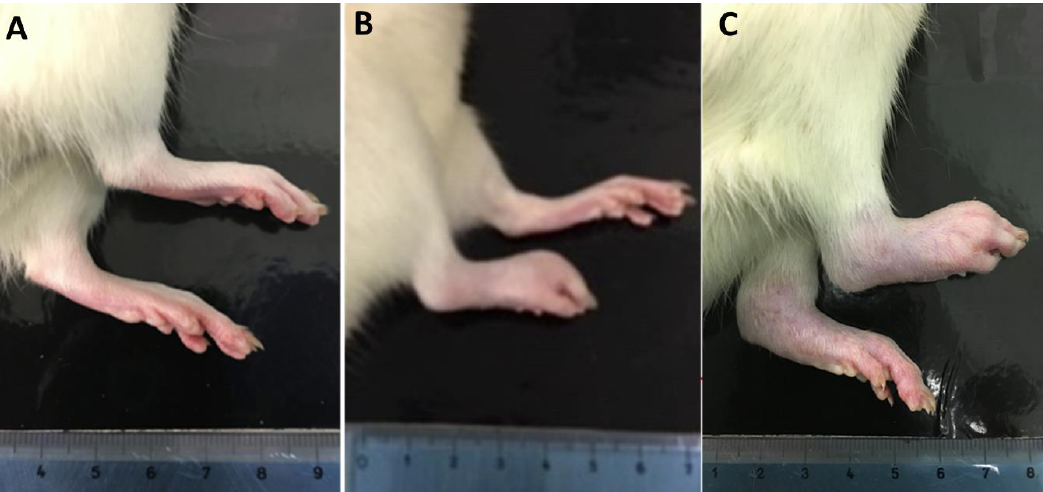
Figure 1. Changes in footpads after complete Freund’s adjuvant (CFA) immunization into the right hind paw of rat. ( A ) Control rat with no inflammation; ( B ) CFA-immunized rat with clinical signs of acute inflammation in the right hind paw and ( C ) CFA-immunized rat with arthritis that typically appears in the left non-injected hind paw about 15 days after CFA immunization.